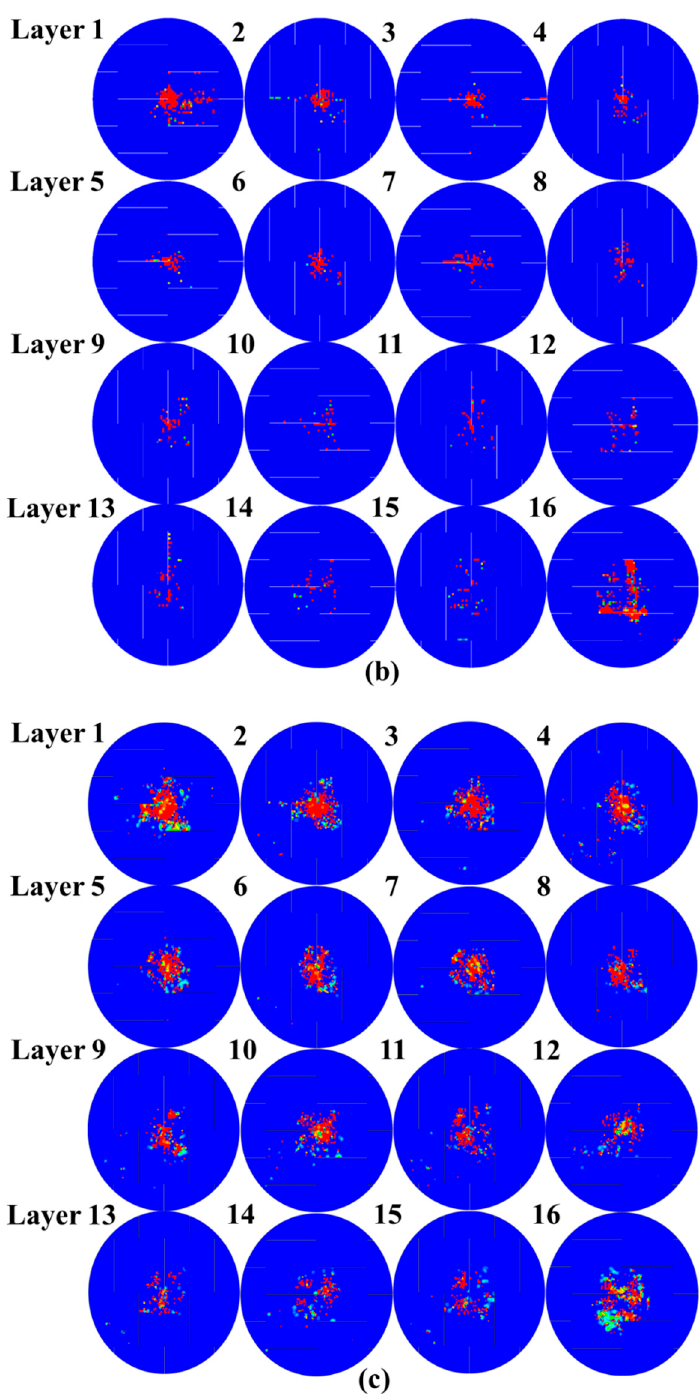
Figure 12. Matrix compression damage of UACS laminates under impacts at ( a ) 4 J, ( b ) 7 J and ( c ) 11